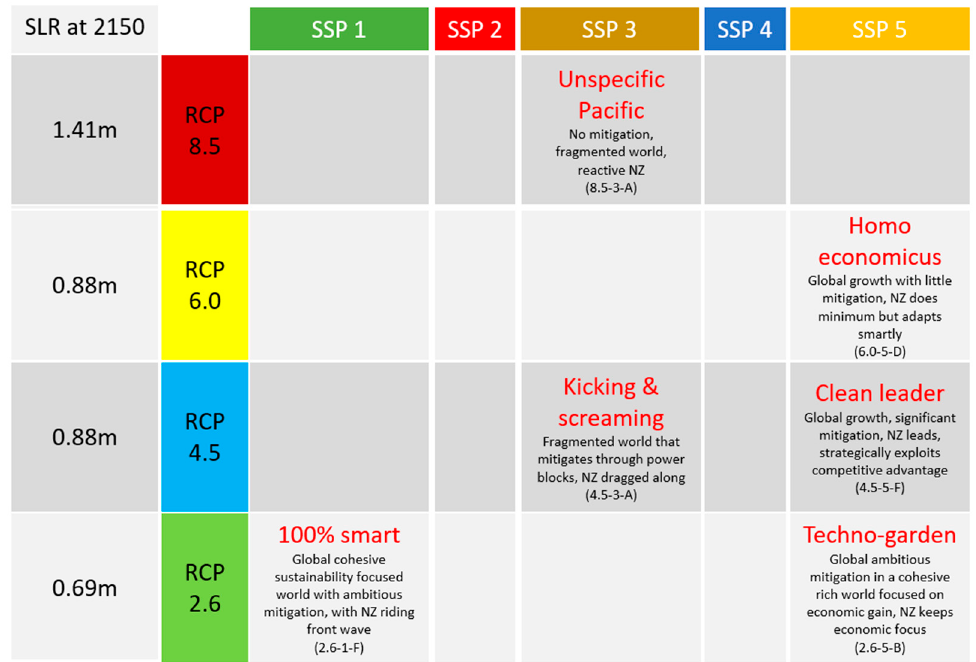
Figure 3. SSP/RCP Matrix showing six plausible future scenarios for New Zealand. Reproduced from Allison et al. [53]; with permission from Engineers Australia, New Zealand Coastal Society, and PIANC 2021; adapted from Lawrence et al. [25].